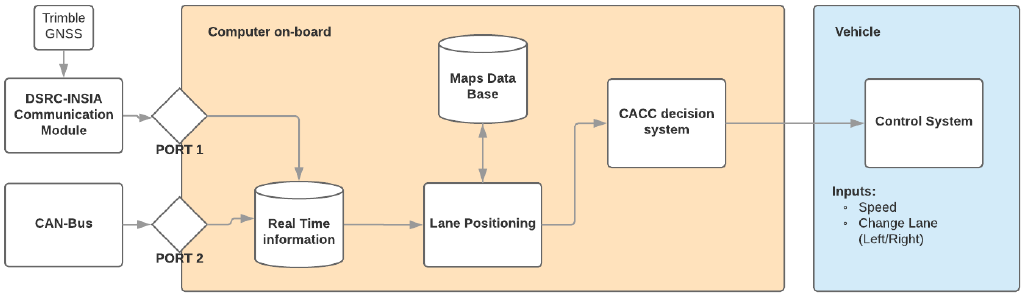
Figure 1. Basic scheme of the system. CACC: cooperative adaptive cruise control; GNSS: global navigation satellite system.